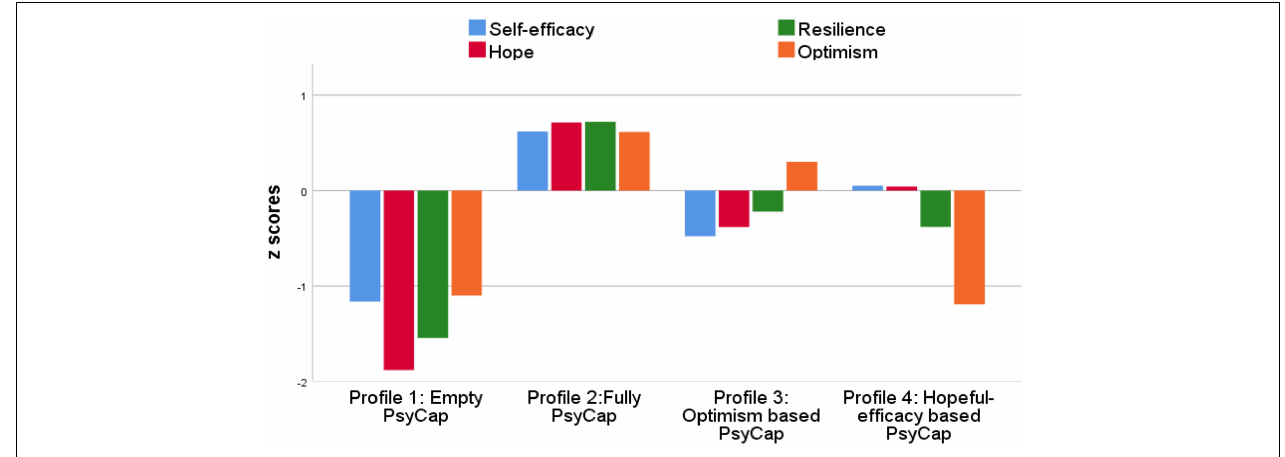
FIGURE 1 | Graphical representation of the PsyCap profiles. TABLE 2 | Means, standard deviations, standard errors, and confidence intervals for the four-cluster model.